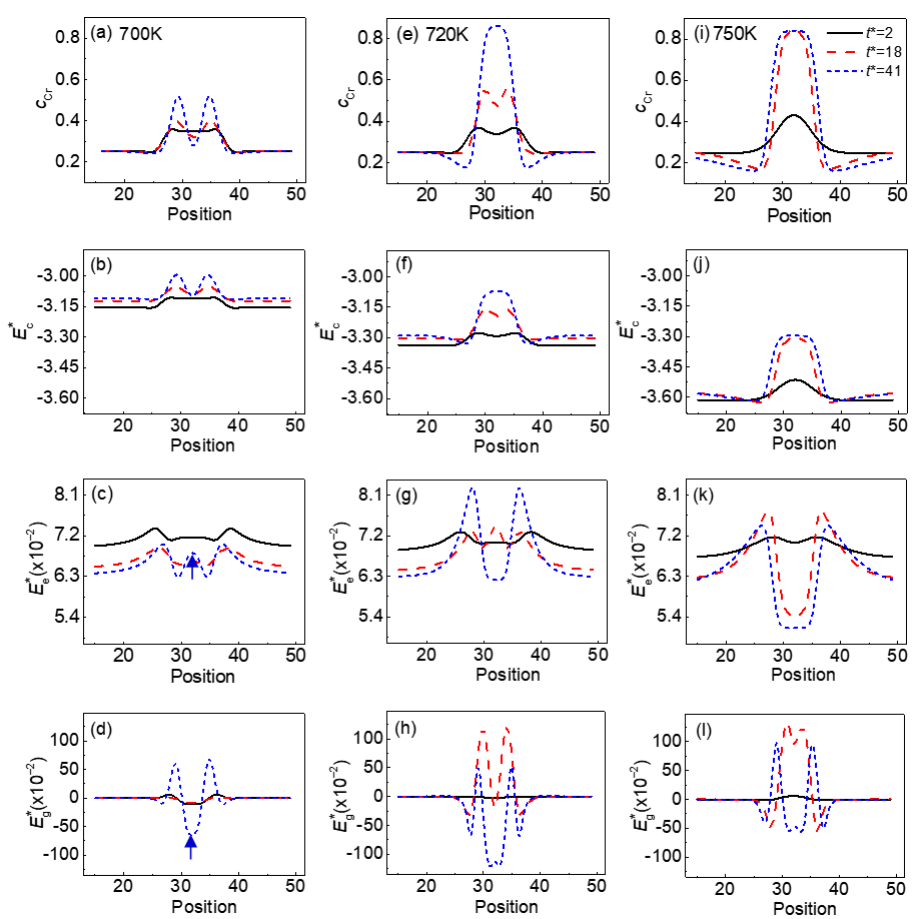
Figure 10. The dimensionless energy density and concentration distributions of Cr across of the = c i = 1 × 10 − 7 at 700 K ( a – d ), 720 K ( e – h ) and 750 K ( i – l ) under Cr-enriched α (cid:48) phase with c i V I ε a xx = − 0.025. ( a , e , i ) concentration of Cr, ( b , f , j ) E ∗ c , ( c , g , k ) E ∗ e , ( d , h , l ) E ∗ g